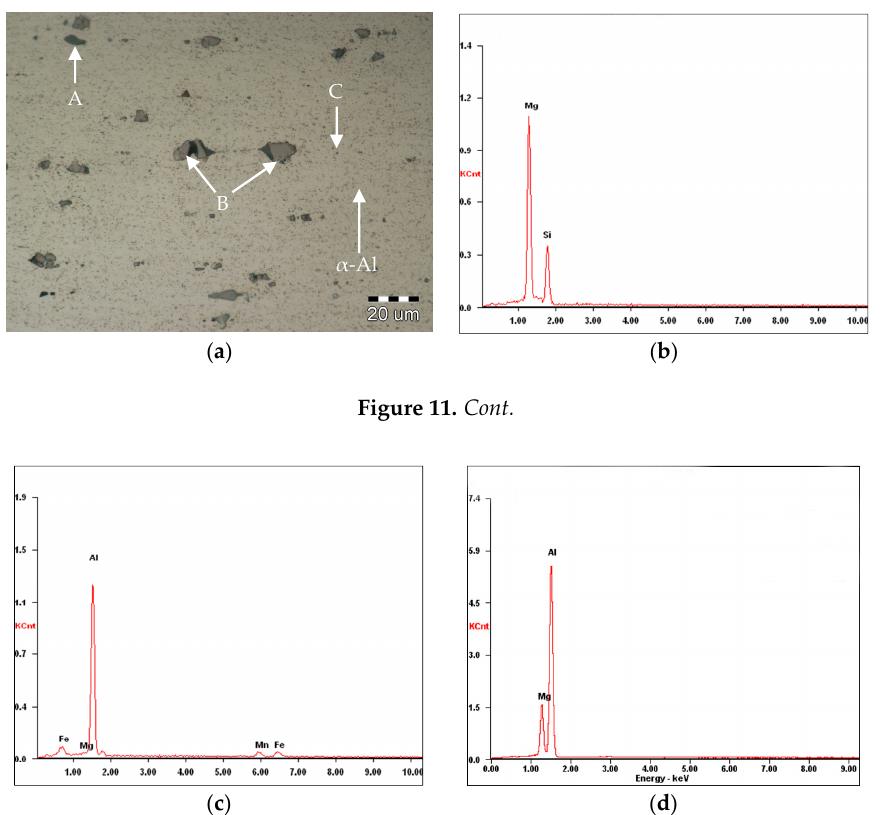
Figure 11. ( a ) Microstructure of the base metal; ( b ) energy-dispersive X-ray spectrometer (EDS) result of the phase particle A (Mg 2 Si); ( c ) EDS result of the phase particle B (Al 6 (Fe, Mn)); ( d ) EDS results of the phase particle C (Al 3 Mg 2 ).